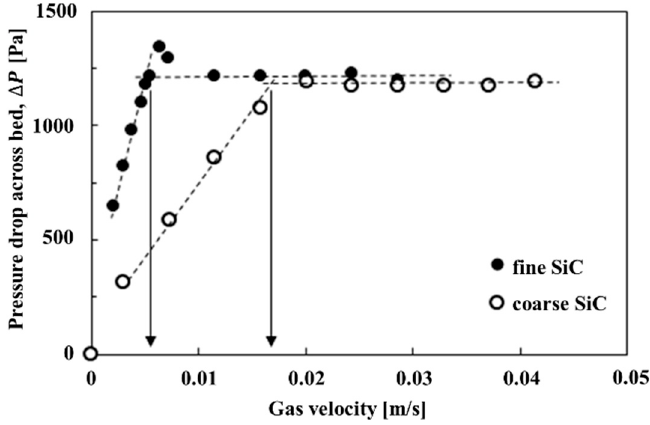
Figure 3. Pressure drop-versus-velocity diagram for determination of U mf .